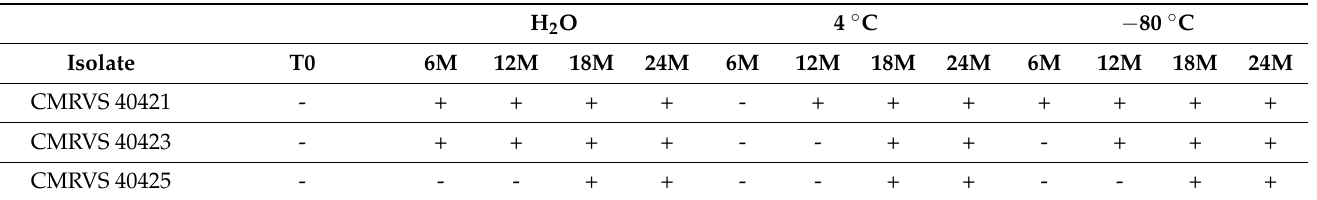
Table 2. Alterations in sucrose assimilation after